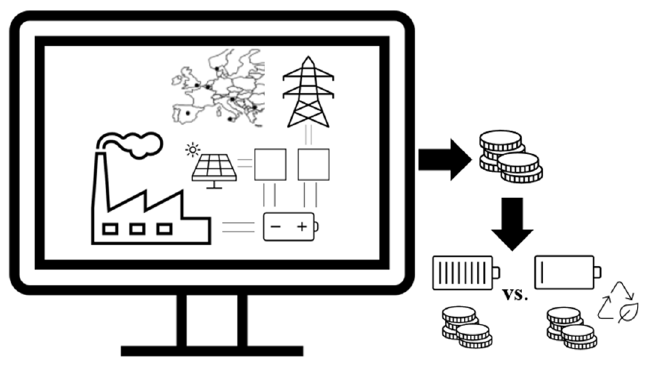
Figure 1. Illustrated study scope.